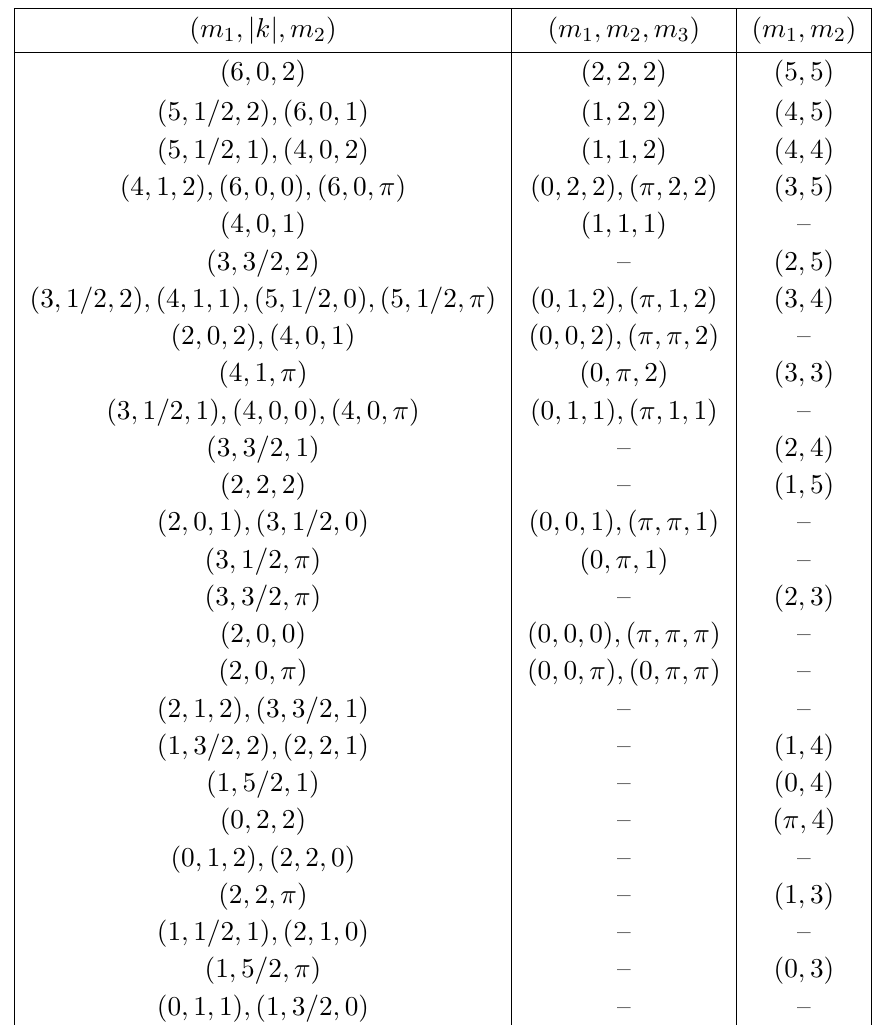
Table 5. Dualities amongst marginal quiver gauge theory descriptions of minimal ( E 6 ; E 6 ) confor- mal matter. The three columns correspond to the quiver gauge theories (6.13), (6.12) and (6.14), respectively. We do not write explicitly the obvious duality between ( m 1 ; k; m 2 ) and ( m 1 ; (cid:0) k; m 2 ), and simply write the Chern-Simons level in terms of an absolute